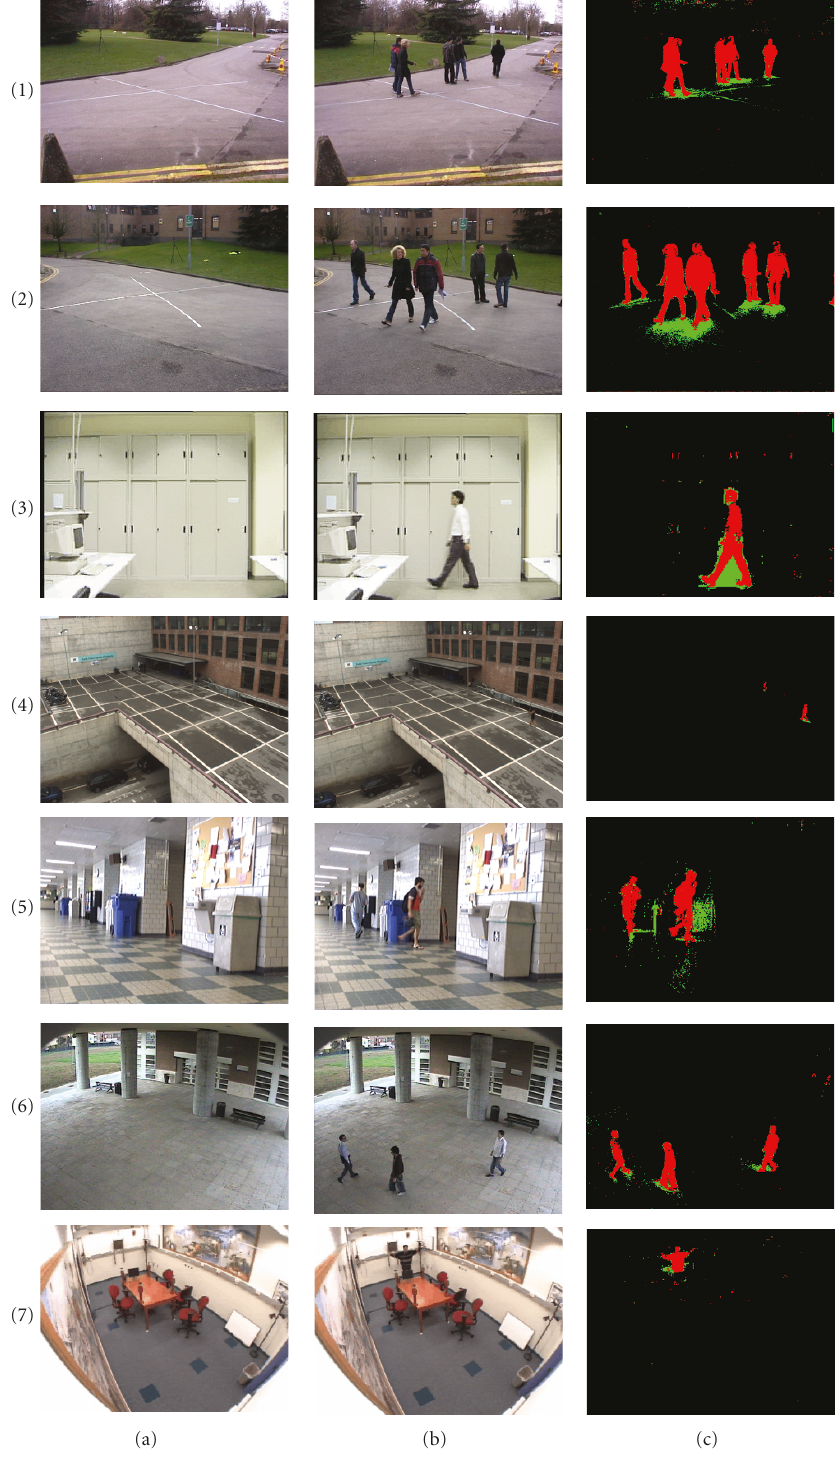
Figure 4: Sample visual results of our background subtraction algorithm in various environment. (a) Background Image, (b) Current Image, and (c) Foreground (red) /Shadows (green) /Background (black) detection. (1) PETS 2009 View 7, (2) PETS 2009 View 8, (3) ATON (Laboratory), (4) ISELAB (ETSE Outdoor), (5) LVSN (HallwayI), (6) VSSN, and (7) ATON